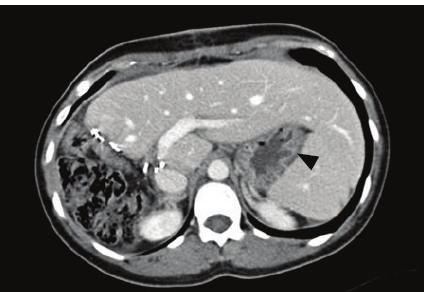
Figure 1: Computed tomography scan of the abdomen with intra- venous contrast for patient KS, one month following open right hepatectomy. There is no evidence of adhesion formation between the stomach and cut liver surface. The stomach (black arrow) is far removed from the cut surface of the liver.